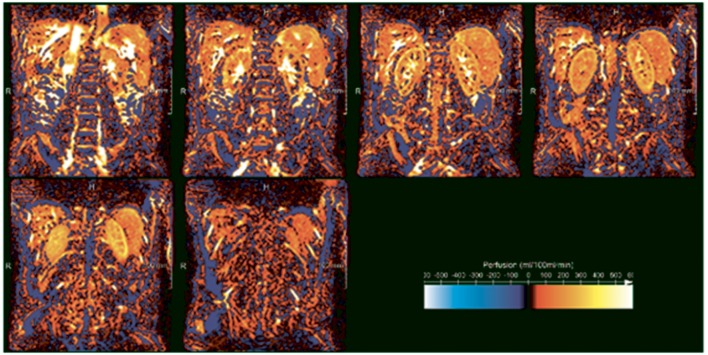
ASL perfusion images of the kidney in a healthy volunteer acquired at our center (unpublished data). White and yellow denote high perfusion, while orange and red denote low perfusion. The difference between the highly-perfused cortex and less highly perfused medulla is clearly visible. In the three upper panels, starting on the left, the high signal intensity regions in the kidney centers reflect the pyelocalceal system.